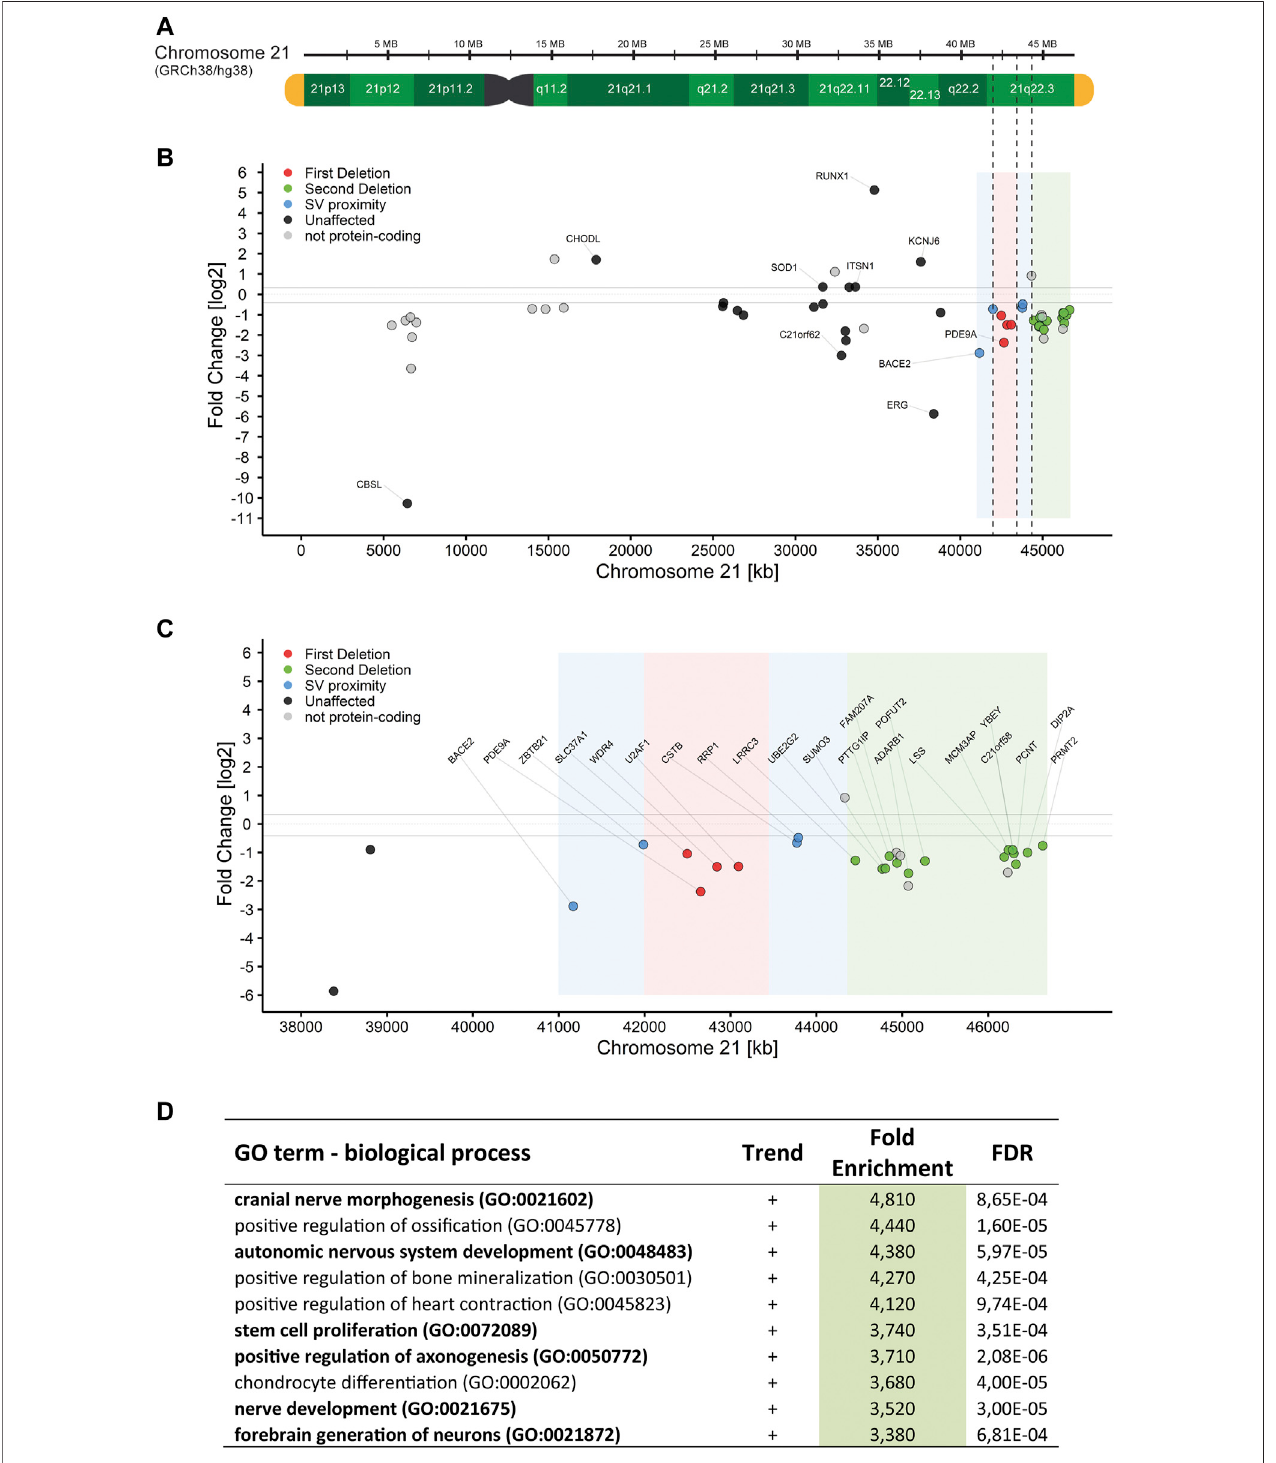
FIGURE 3 | RNA-Seq of NESCs in RD_P26 reveals downregulated genes on chr21q (A) Graphical representation of chromosome 21 based on the human reference genome GRCh38/hg38, marked for the two deletions on chr21q (dashed) (B) Gene expression in RD_P26 of protein-coding genes on chromosome 21. Genes are colored according to their location in deletion 1 (red), deletion 2 (green) as well as the 1 Mb vicinity close to the SVs. Non-protein-coding genes are included (paledots).The fi vehighestand fi velowestexpressedgenesarelabelled (C) GeneexpressioninRD_P26,zoomedinonthedistalregionofchromosome21.Color coding as in panel B. All protein-coding genes located in the deletions and close proximity are labelled (D) Top ten fi ndings of the pathway analysis for differential expressed genes in RD_P26. Pathways related to brain tissue are marked in bold. Complete list can be found in Supplementary Table S3 .